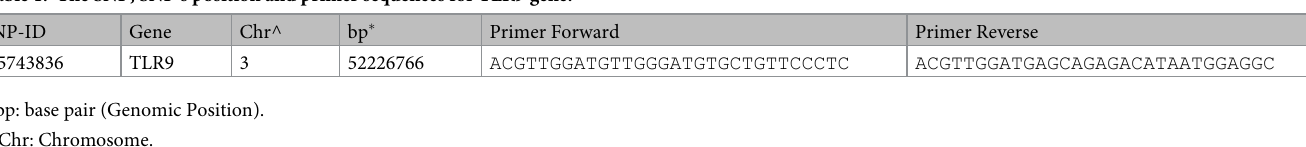
Table 1. The SNP, SNP’s position and primer sequences for TLR9